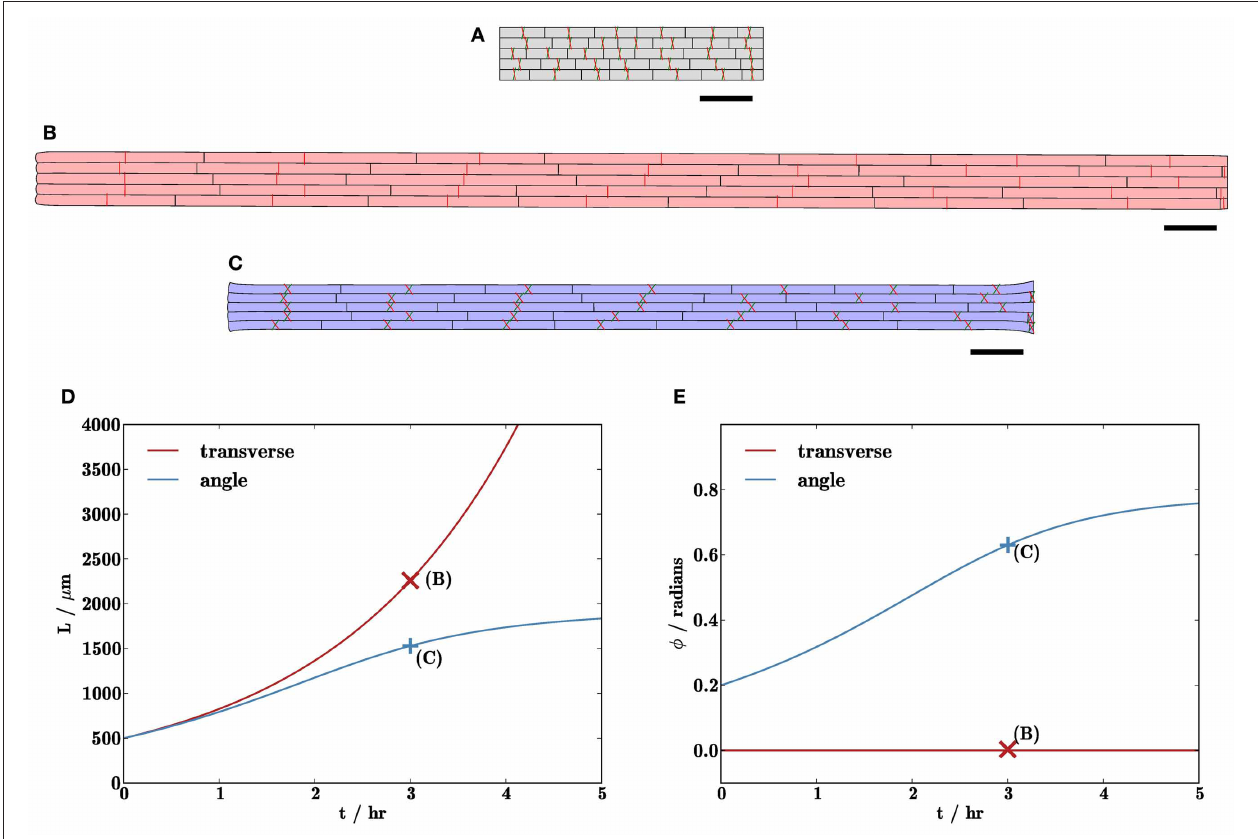
FIGURE 7 | Cell wall microfibril reorientation can slow organ elongation. (B,C) Simulation results after 3hr with initial tissue geometry displayed in (A) . In (B) , microfibrils (indicated by red and green lines) are initially aligned with the y -axis, whilst those in (C) are oriented at angles of ± 0 . 2 to the y -axis. (D) shows the lengths of the organs, and (E) shows the mean angle φ between the microfibril orientations and the y -axis. The organ in (B) grows (roughly)